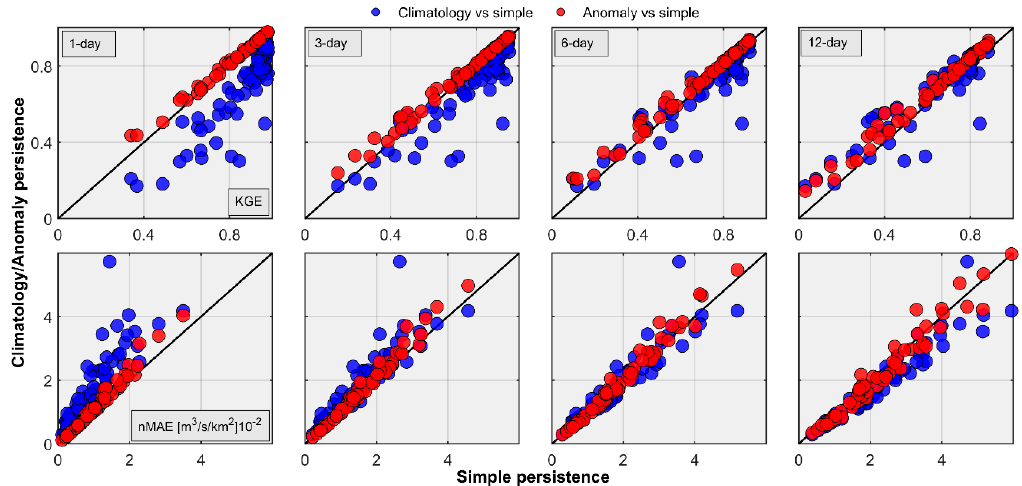
Figure 4. One-to-one relationship of skill metrics between climatology and simple persistence-based forecasts (blue), and between anomaly persistence-based forecasts and simple persistence-based forecasts (red). The columns show 1, 3, 6 and 12 day lead times, while the rows show Kling–Gupta efficiency (KGE ) and normalized mean absolute error ( nMAE ), respectively.